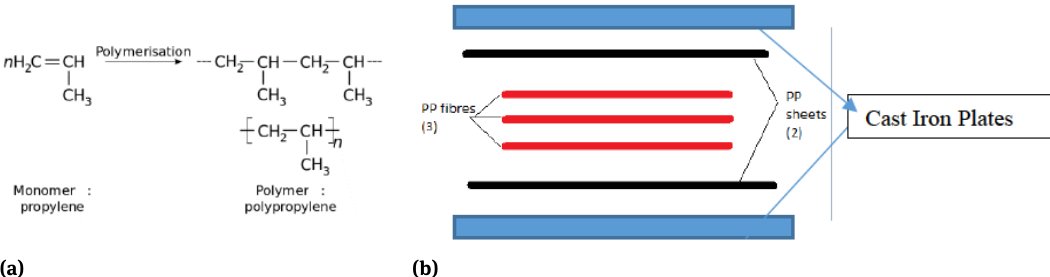
Figure 3: (a) Polymeric structure of Polypropylene (b) Schematic diagram of Fibre lay up of HOT compaction method